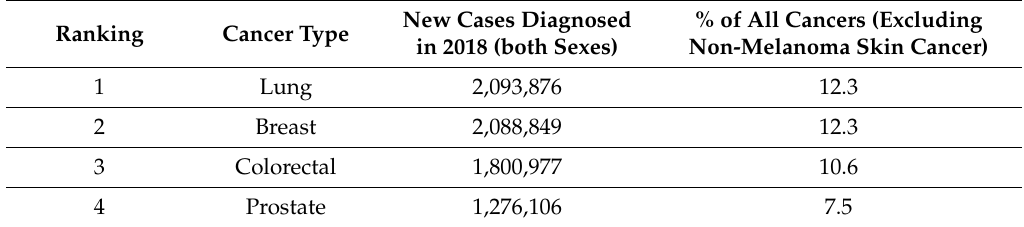
Table 1. The four most common cancers worldwide (modified from the 2018 world cancer statistics [7]). New Cases Diagnosed % of All Cancers Ranking Cancer Type in 2018 (both Sexes)